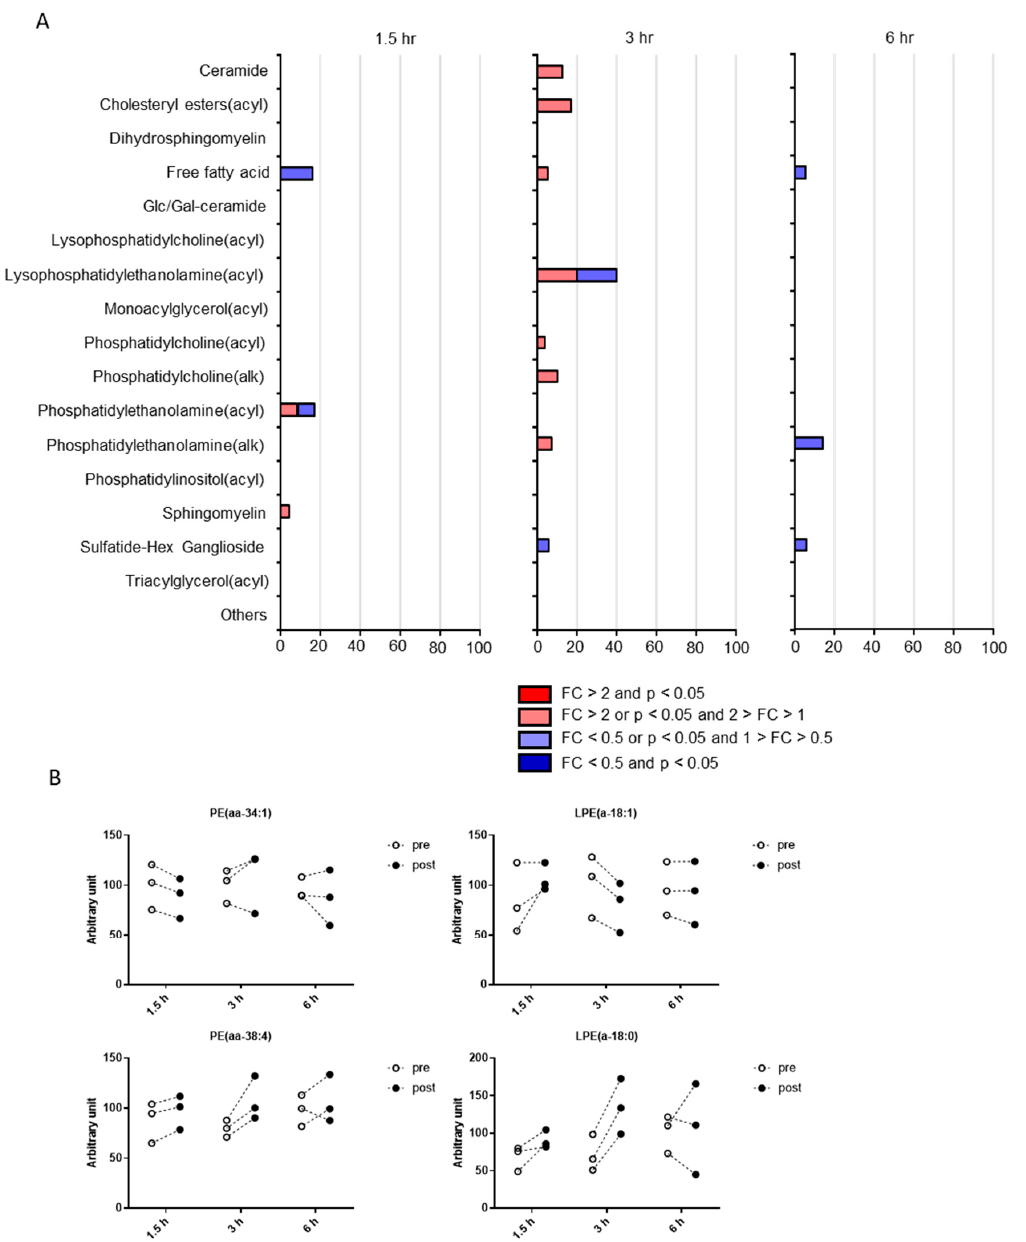
Figure 6. Pathway occupancy rates of putative lipids altered by postprandial effects. ( A ) Pathway occupancy rates are listed as percentages. Statistical significance using hypergeometric tests is indicated as follows: * p < 0.05, ** p < 0.01. ( B ) Levels of lipids in the lysophosphatidylethanolamine (LPE) pathway and their precursor, phosphatidylethanolamine.